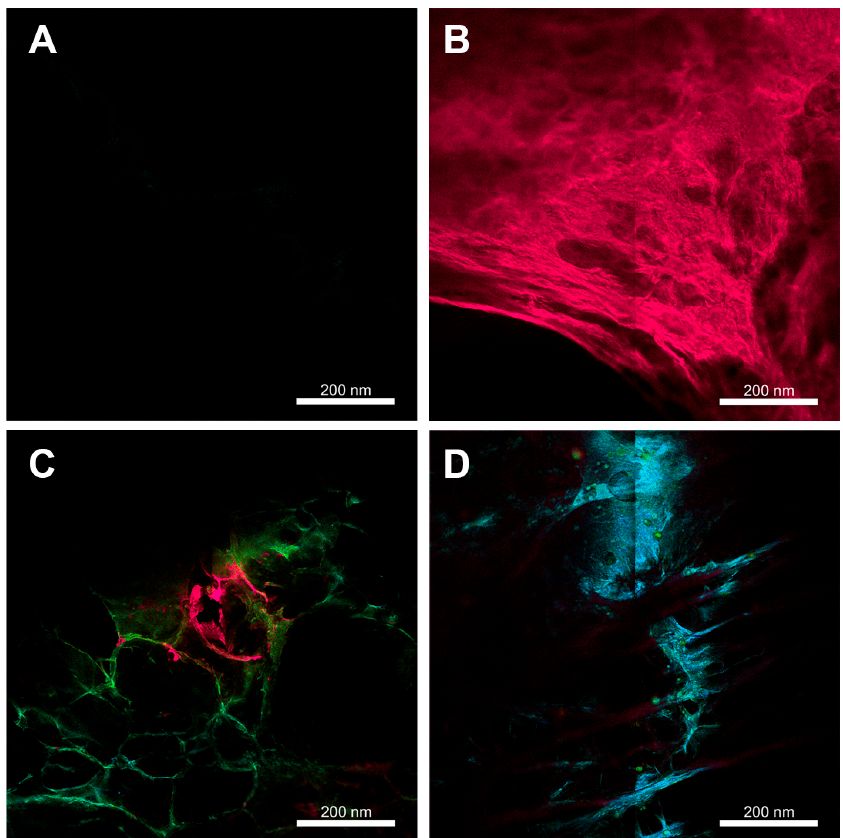
Figure 7. Confocal fluorescence microscopic images of the formulations: ( A ) BNCH, ( B ) BNCH/MB1, ( C ) BNCH/P1, and ( D ) BNCH/P1/MB1.